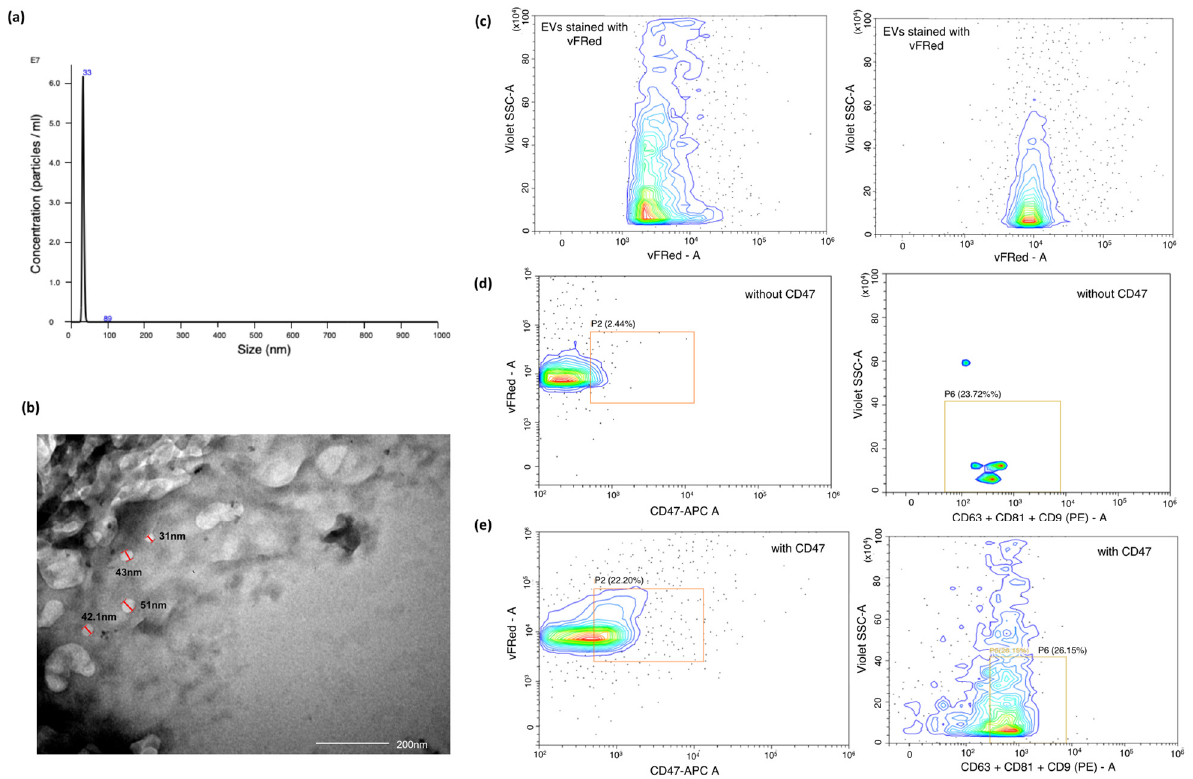
Figure 1. Characterisation of exosomes based on size, scatter and antigen expression. ( a ) Representative TEM images of exosomes from OSCC patients, (Scale: 200 nm); ( b ) Estimation of size and concentration of salivary exosomes from OSCC patients using Nanoparticle Tracking Analysis (NTA). The x-axis indicates the size distribution of particles and the y-axis shows the signal intensity in NTA; ( c – e ) Characterisation of exosomes by flow cytometry. We used a membrane-binding dye vFluor Red to stain exosomes and examined the violet side scatter v/s vFluor Red staining of these exosomes. This profile was similar to that of Lipo-50 liposomes used as a reference standard. Salivary exosomes were stained with antibodies against tetraspanins (CD63, CD81 and CD9) labelled with PE, and APC labelled CD47 antibody. We identified a distinct CD47+/vFluor Red+ population in the exosome population that was absent in the unstained control. This population was then examined for tetraspanin expression and showed detectable levels of tetraspanins. Since these particles stain with vFluor Red, have a violet side scatter similar to 50 nm liposomes, express CD47 and tetraspanins, we concluded that these are exosomes.